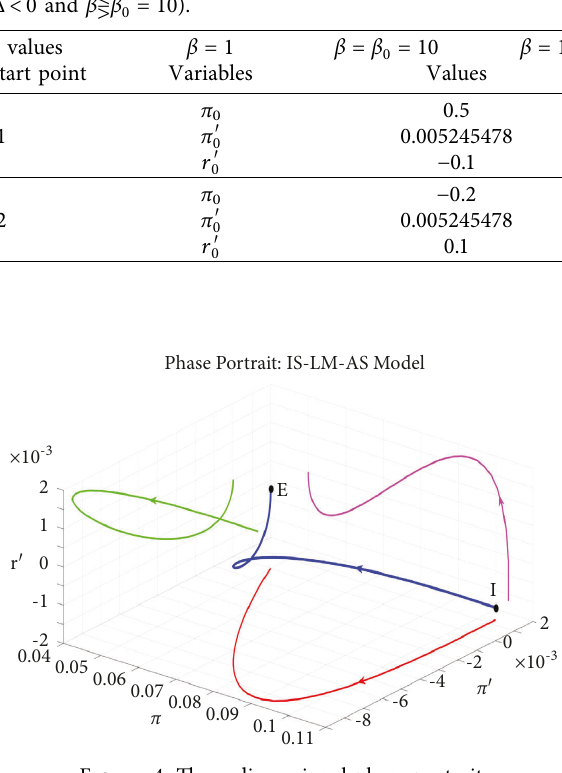
Table 5: Initial values of the endogenous variables of the